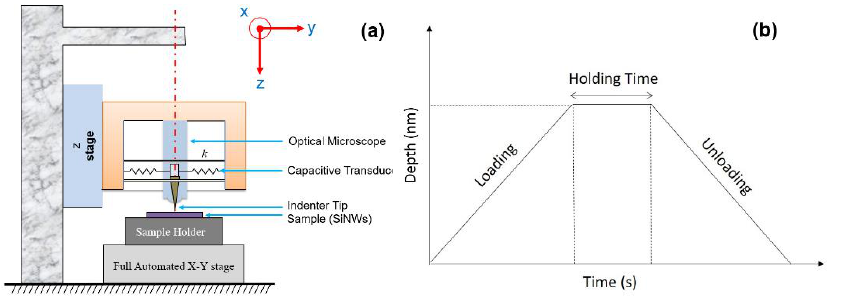
Figure 3. Nanoindentation setup ( a ) and load function during the indentation test ( b